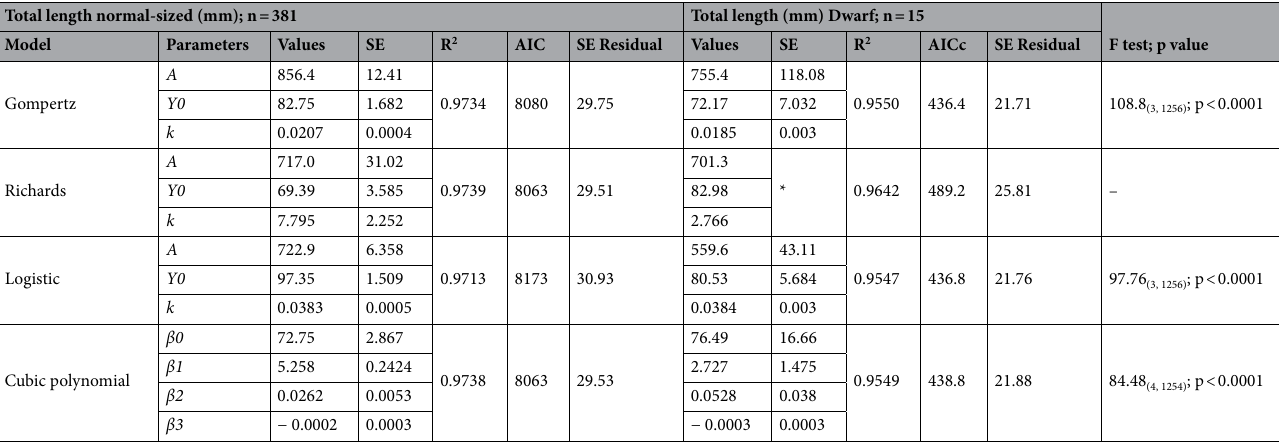
Table 2. Results from four models fitted to total length growth to normal-sized and dwarfs hyacinth macaw. Parameters of the Gompertz, Richards and Logistic models: A upper asymptote (i.e. predicted adult size), k maximum relative growth rate, Y0 initial value of the asymptotic curve. Cubic polynomial models are represented with four parameters: β0 intercept, β1 maximum relative growth rate, β2 upper asymptote, β3 weight loss begins. *Very wide confidence interval = CI > 95%.